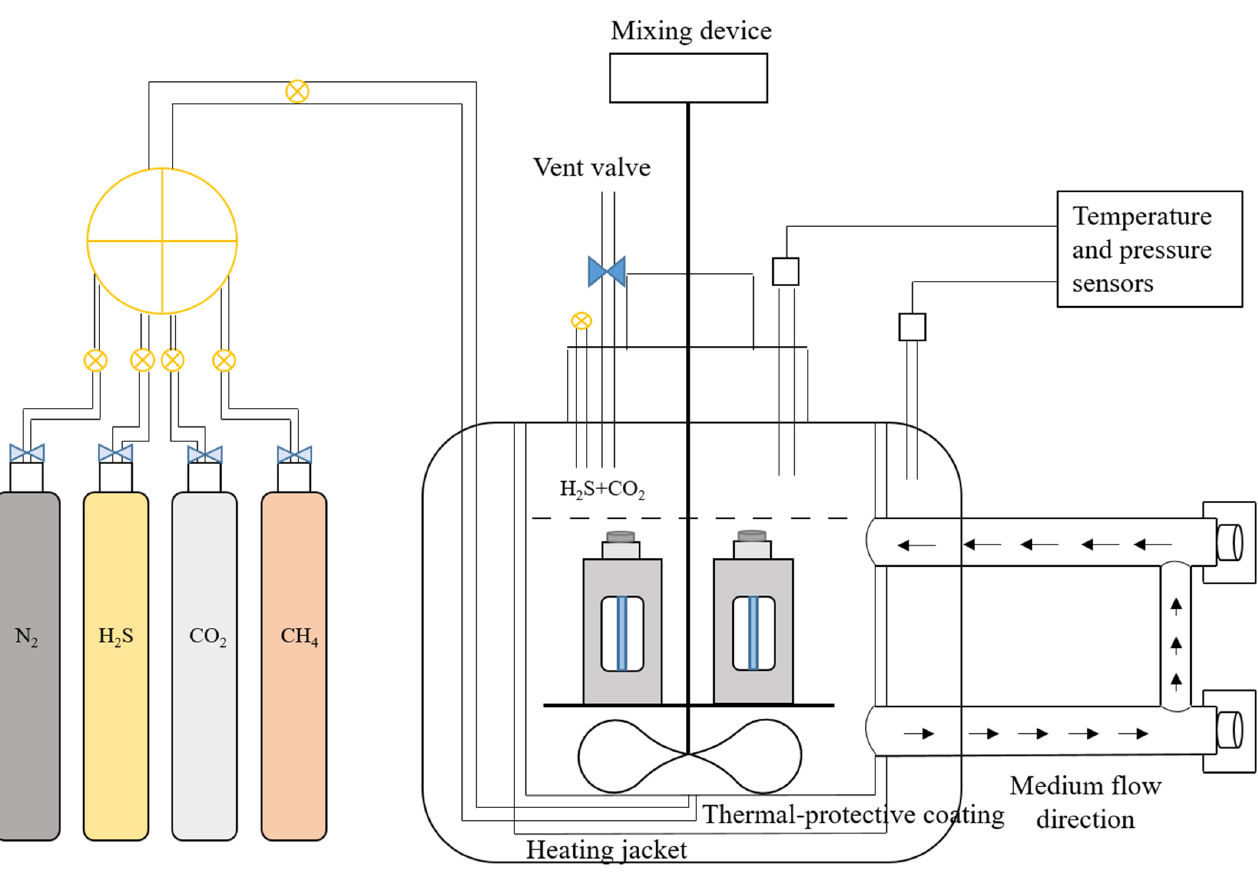
Figure 4. The stress corrosion device with constant load.